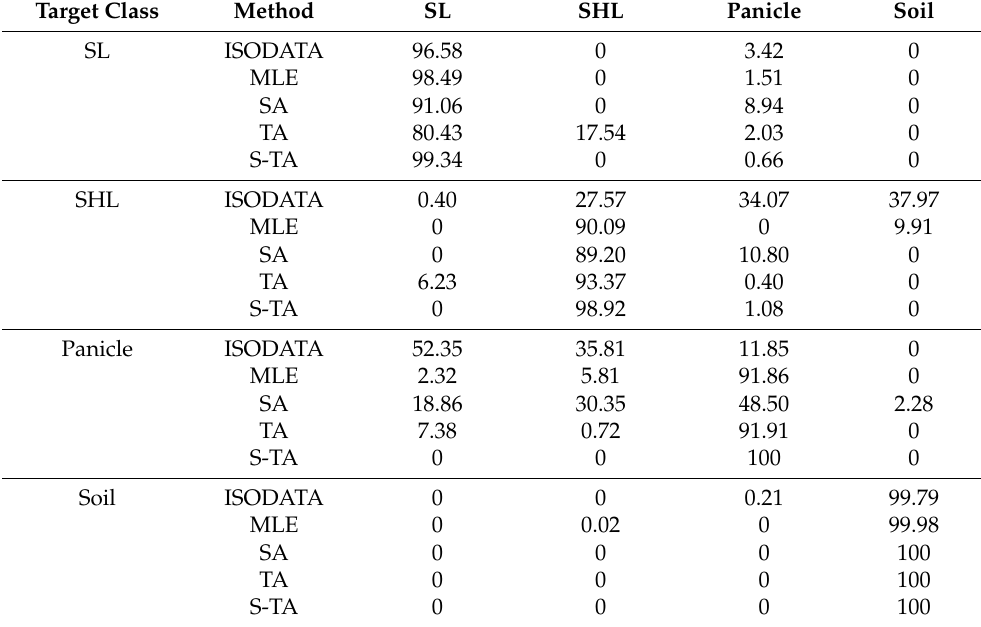
Figure 5. A comparison between ( a ) the original image at heading stage and ( b ) the masked results of the panicles based on textural analysis (TA). Table 4. The confusion matrix (%) of each class based on different classification methods in the heading